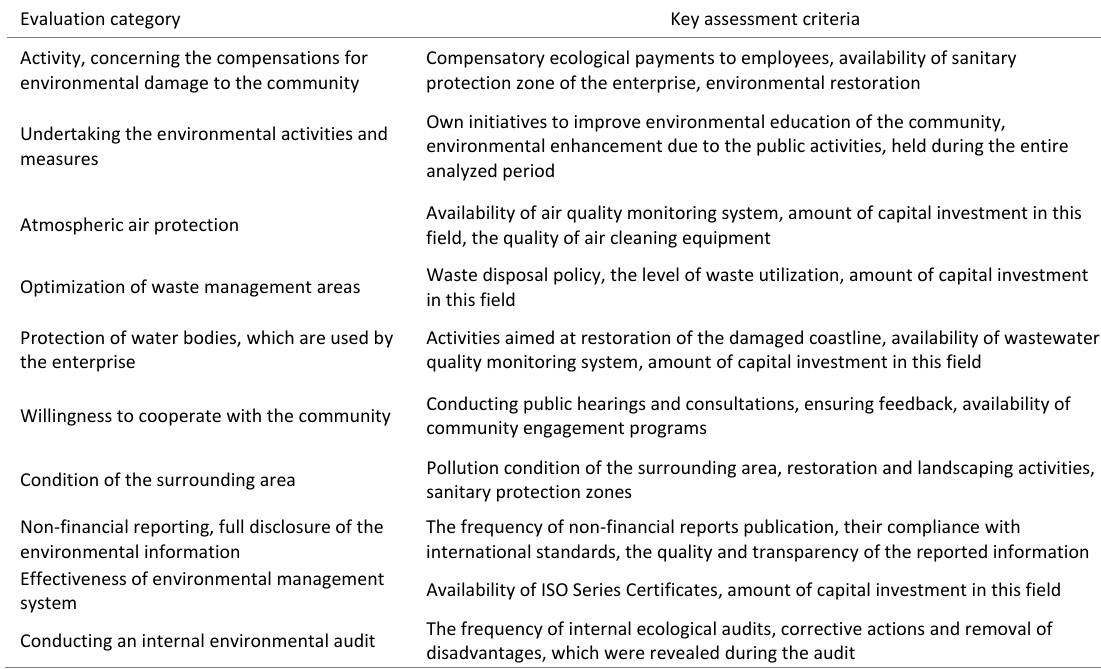
Table 1: The system for assessing the environmental initiative of industrial enterprises Evaluation category Key assessment criteria